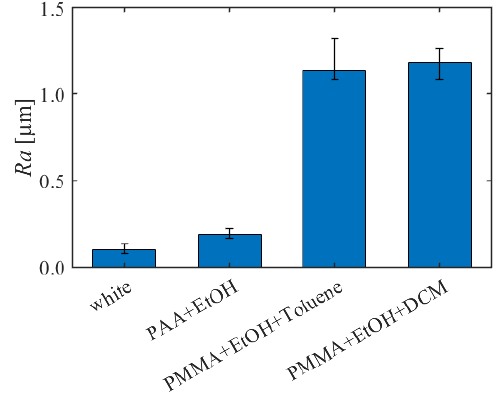
Figure 13. Comparison of surface roughness in different dye concentrations.